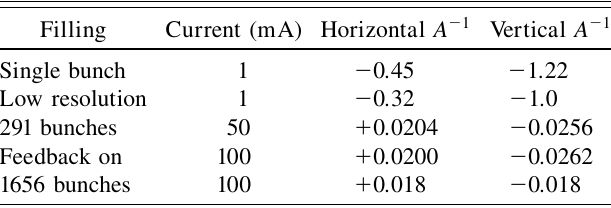
TABLE II. Measured tune slopes in HER of PEP-II.